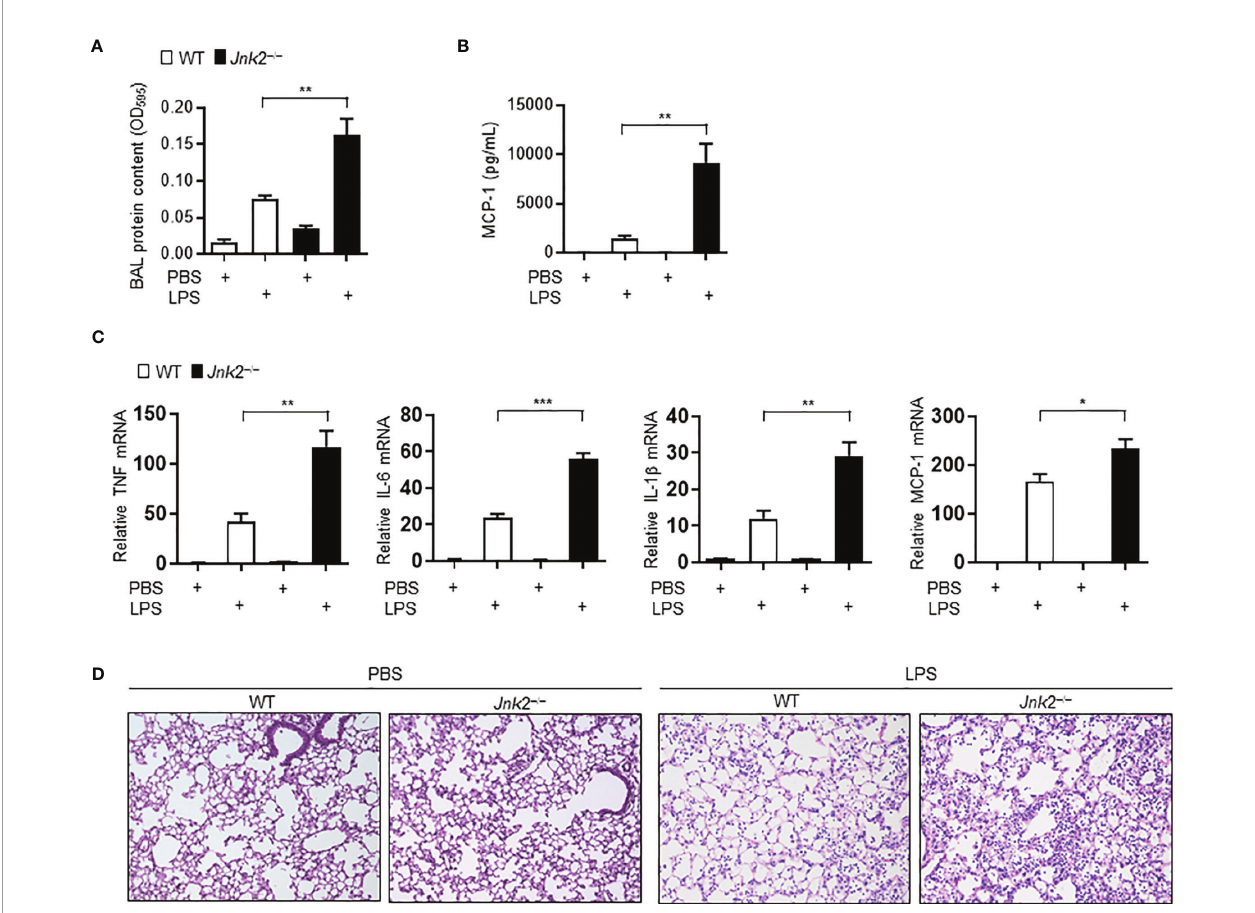
FIGURE 1 | Loss of JNK2 aggravates lung in fl ammation and injury in mouse model of LPS-induced acute lung injury. Wild-type and JNK2 KO mice were subjected to i.t. LPS-induced ALI. Two days later, mice were harvested. (A, B) Protein content (A) and production of MCP-1 (B) in the BAL fl uid. PBS: N=3-6. LPS: N=5-6. (C) mRNA expressions of in fl ammatory cytokines in whole lung homogenates as indicated. N=4. (D) Sectional lung histology from PBS- or LPS- treated wild-type and JNK2 KO mice. Data are presented as means ± sem. * p < 0.05; ** p < 0.01; *** p <